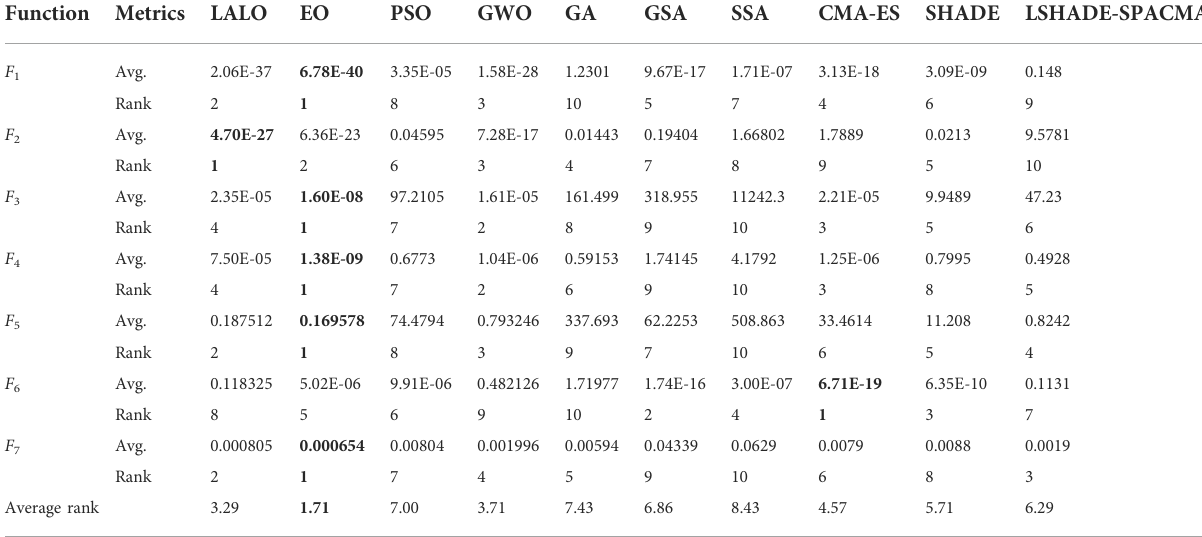
TABLE 4 Fitness standard deviation and ranks obtained by different algorithms for unimodal benchmark functions in 30 runs.